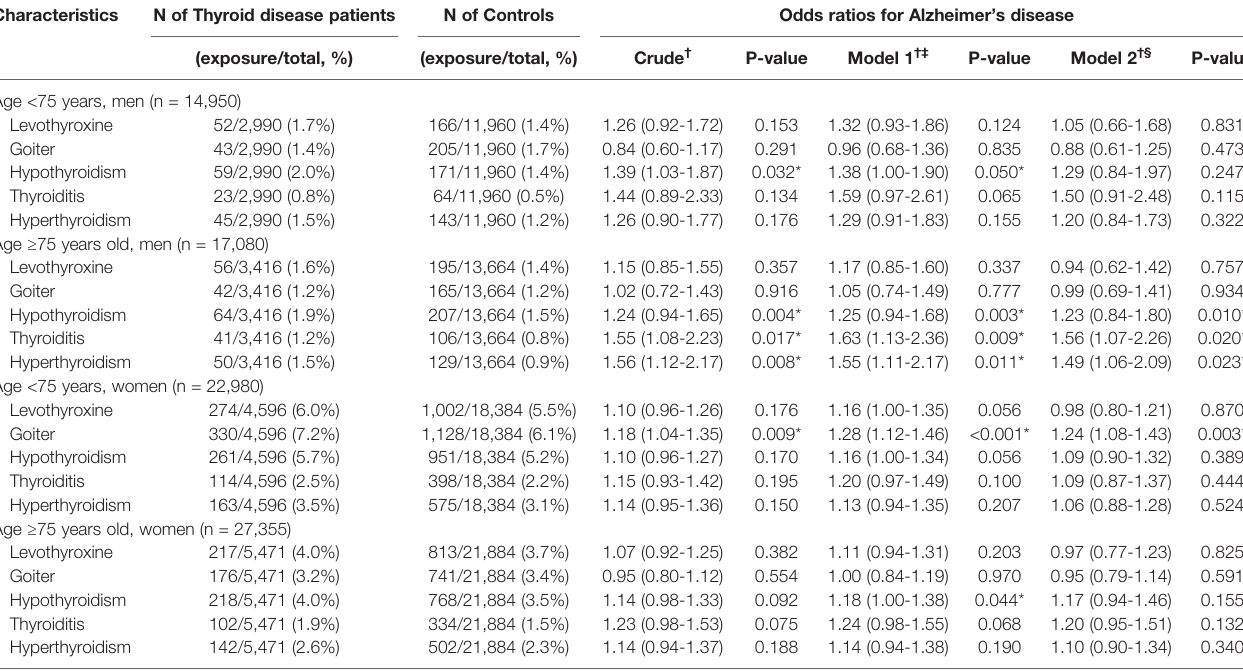
TABLE 3 | Subgroup analyses of crude and adjusted odds ratios (95% con fi dence intervals) associated with levothyroxine treatment, goiter, hypothyroidism, thyroiditis, and hyperthyroidism in Alzheimer ’ s disease patients compared to control participants strati fi ed by age and sex. Characteristics N of Thyroid disease patients N of Controls Odds ratios for Alzheimer ’ s